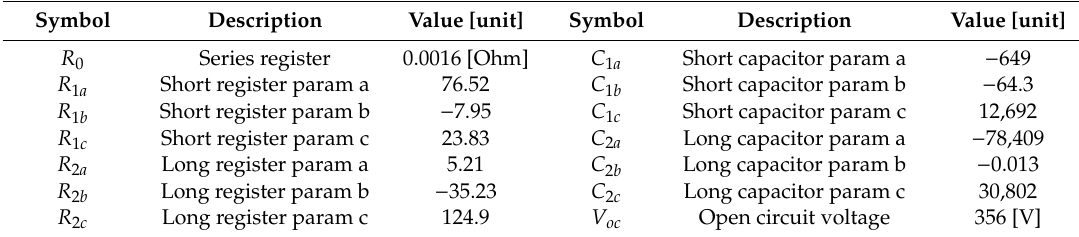
Table 2. Battery model parameters.